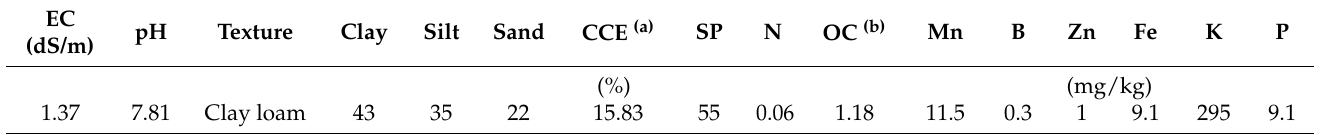
Table 1. Some physicochemical characteristics of the soil in the studied